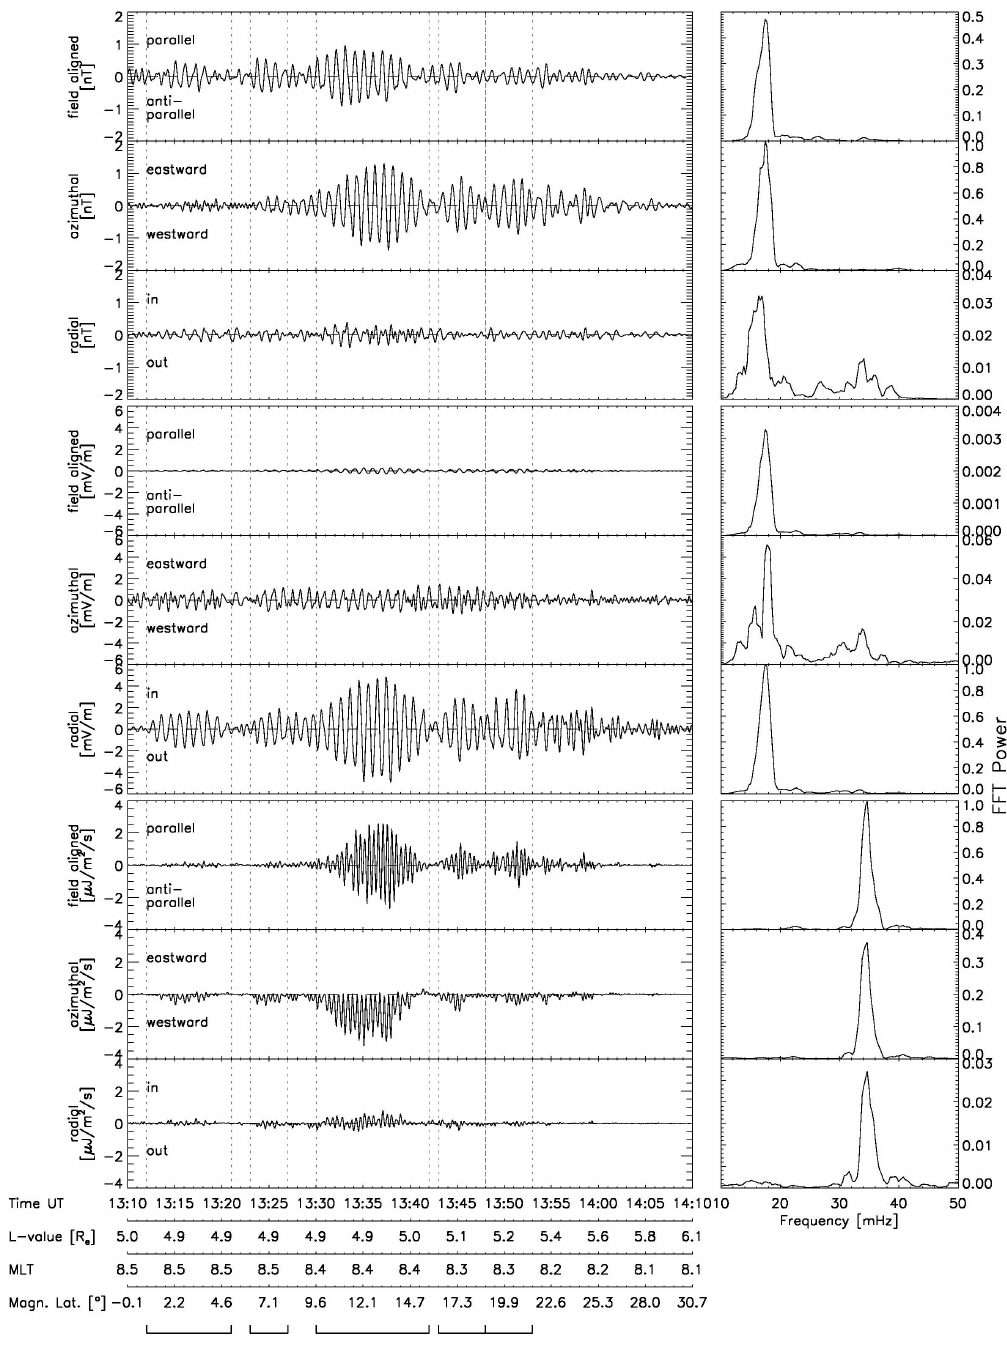
Fig. 3. Summary of field data in local dipole coordinates from Cluster 3. The top three panels show the magnetic field, followed by the electric field and the oscillatory Poynting flux. The right hand side panels show the respective smoothed Fourier